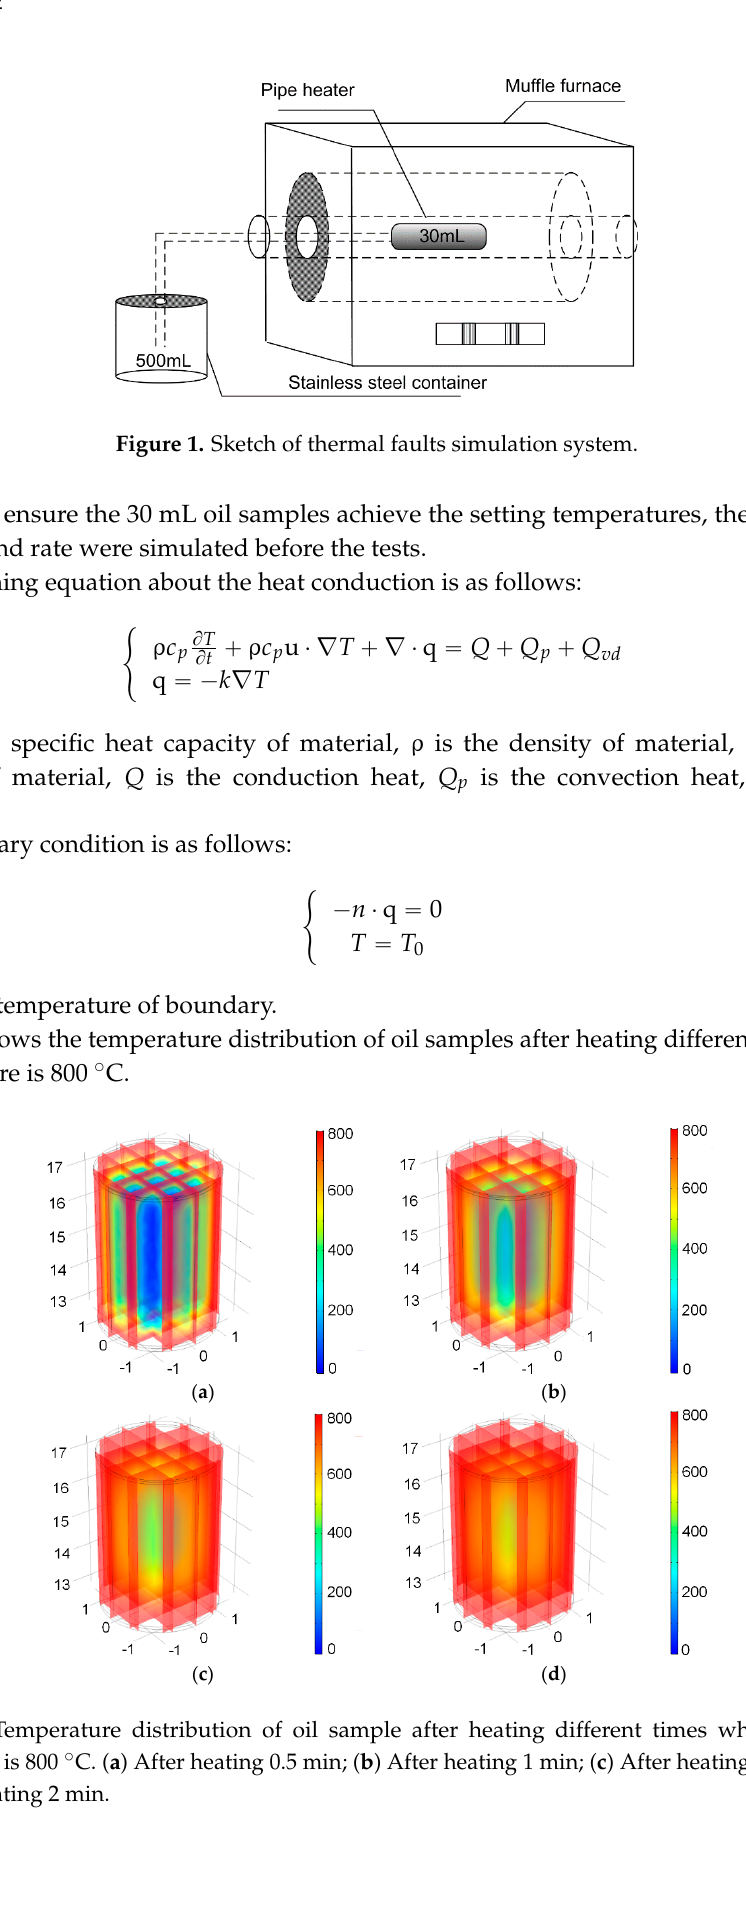
Figure 2. Temperature distribution of oil sample after heating different times when the oven temperature is 800 °C. ( a ) After heating 0.5 min; ( b ) After heating 1 min; ( c ) After heating 1.5 min; and ( d ) After heating 2 min.